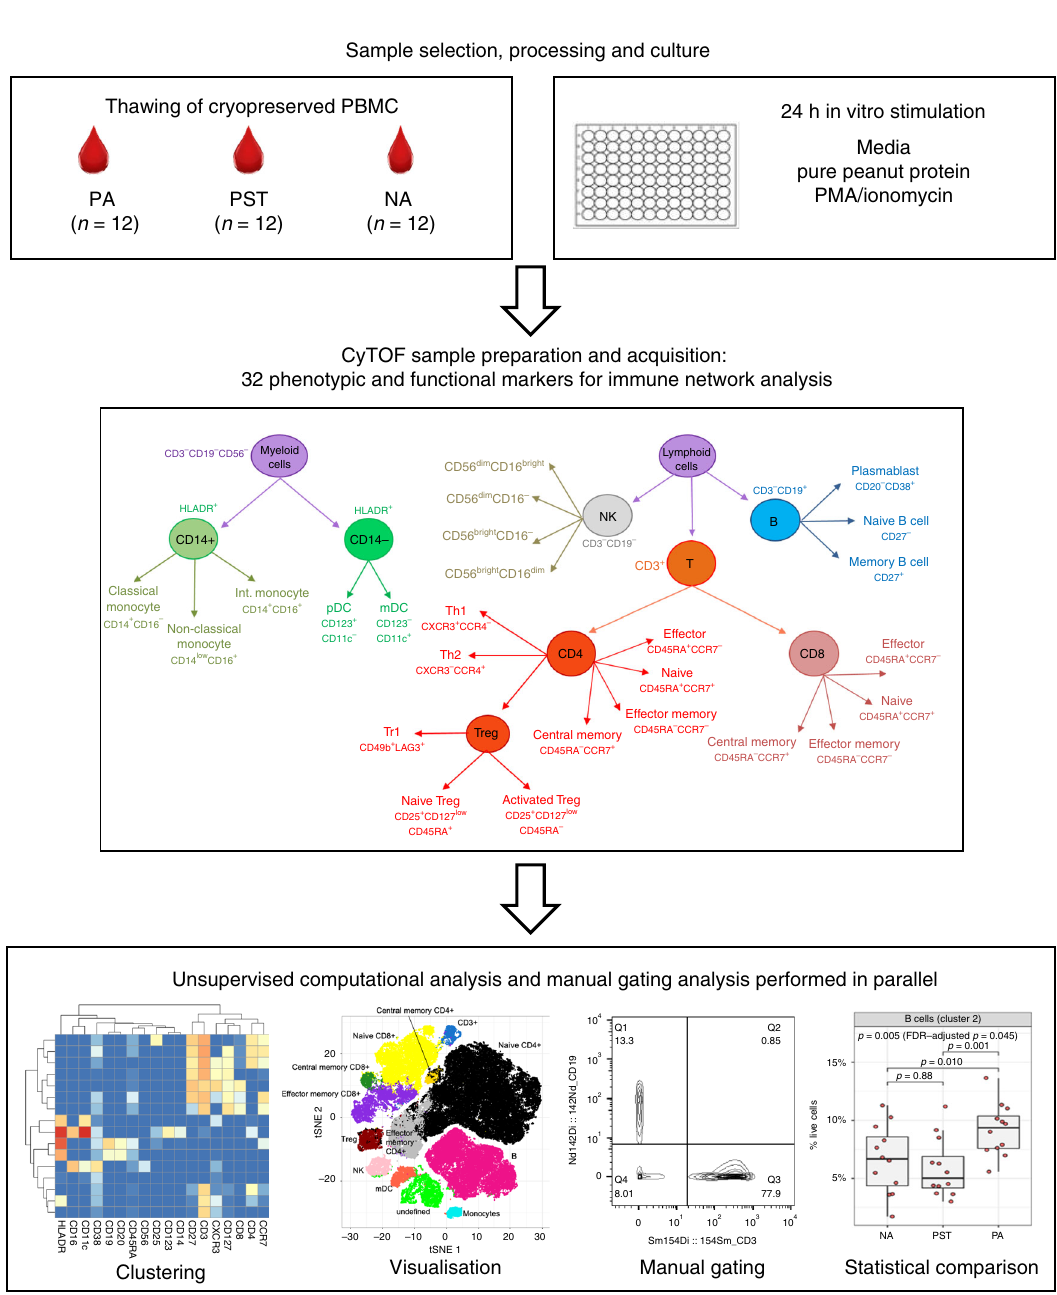
Fig. 1 Experimental work fl ow for mass cytometry analysis of PBMCs from 1-year-old infants. Cryopreserved PBMCs from n = 12 peanut-allergic (PA), n = 12 peanut-sensitized tolerant (PST), and n = 12 non-allergic (NA) healthy 1-year-old infants were thawed and underwent a 24 h stimulation with media (control), pure peanut protein (speci fi c stimulation), or PMA/ionomycin (nonspeci fi c stimulation). Samples were barcoded and stained with a panel of antibodies against 24 surface markers and 8 intracellular markers, and analyzed with a Helios Mass Cytometer. For data analysis, unsupervised computational analyses (clustering and visualization) and manual gating analyses were performed in parallel, along with statistical analyses to identify immune signatures signi fi cantly different between the clinical this high-dimensional data, we performed a Uniform Manifold PST infants, and NA controls. Results of our unsupervised clus- Approximation and Projection (UMAP) analysis as shown in tering, followed by mixed-effects model analysis, revealed signi fi cant Fig. 3c. The cells were color highlighted by their respective differences between the three groups in the abundance of two FlowSOM cluster. CD4 T-cell subpopulations, CD8 T-cell clusters, corresponding to the naive CD4 T-cell cluster ( p = 0.007, χ 2 = 9.9, false discovery rate (FDR)-adjusted p = 0.045, χ 2 -test, subpopulations, B-cell populations, and the myeloid populations Fig. 4a) and the CD19 ++ HLADR ++ B cell (B-cell cluster 2) ( p = cluster together within two-dimensional space, corresponding 0.005, χ 2 = 10.8, FDR-adjusted p = 0.045, χ 2 -test, Fig. 4b). Pairwise well to the automatically de fi ned clusters. post-hoc analyses revealed that PA infants show increases in the frequency of these B cells relative to PST and NA infants ( p = 0.001, Immune signatures that discriminate allergy from tolerance . χ 2 = 10.2 and p = 0.01, χ 2 = 6.6, respectively, χ 2 -test) (Fig. 4b). PST We next compared resting cell populations between PA infants,